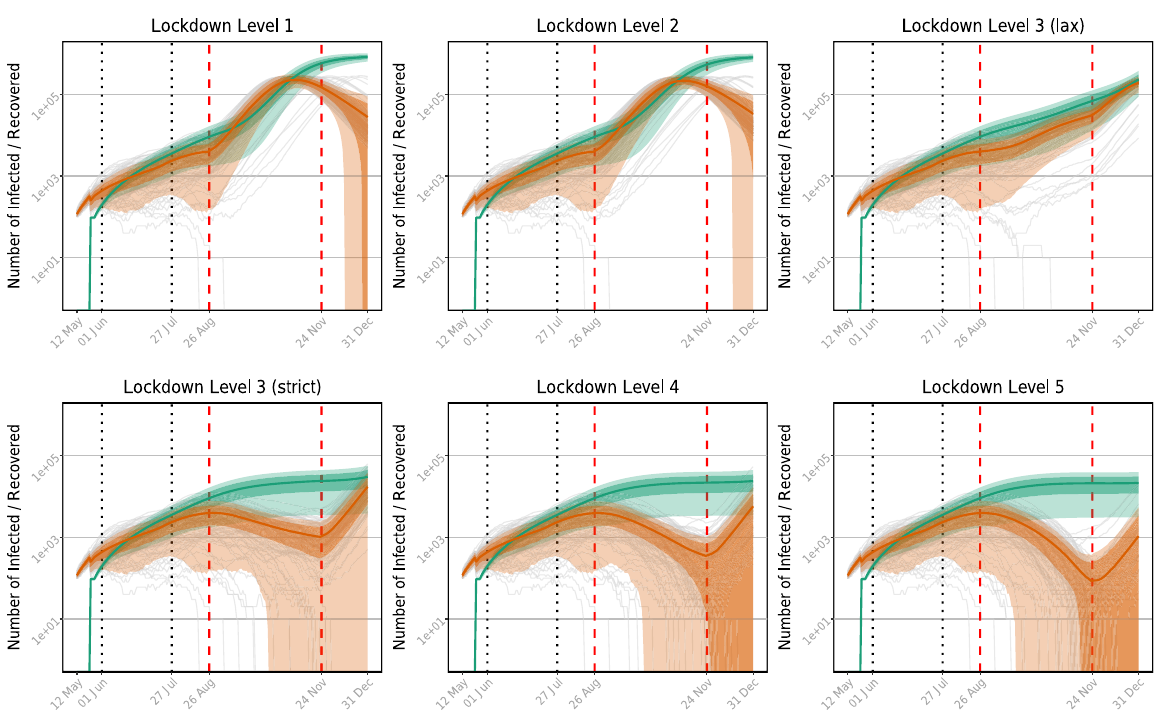
Fig. 9 Simulated infection dynamics in NMBM with an anticipated 90 day lockdown from 26 August 2020 on. All lockdown measures end after 90 days on 24 November. Compared to the lockdown scenarios of 30 or 60 days (Figs. 7 and 8), the simulation of strict lockdown levels (from level 3 upwards) corresponds with an increased number of dying-out infections during the measures period. In the case of lockdown levels 4 and 5, the extended measure period reduced active infections to a level, that multiple infection chains end even in the days after ending the lockdown measures. Nevertheless, the remaining infection chains return to exponential growth rates.